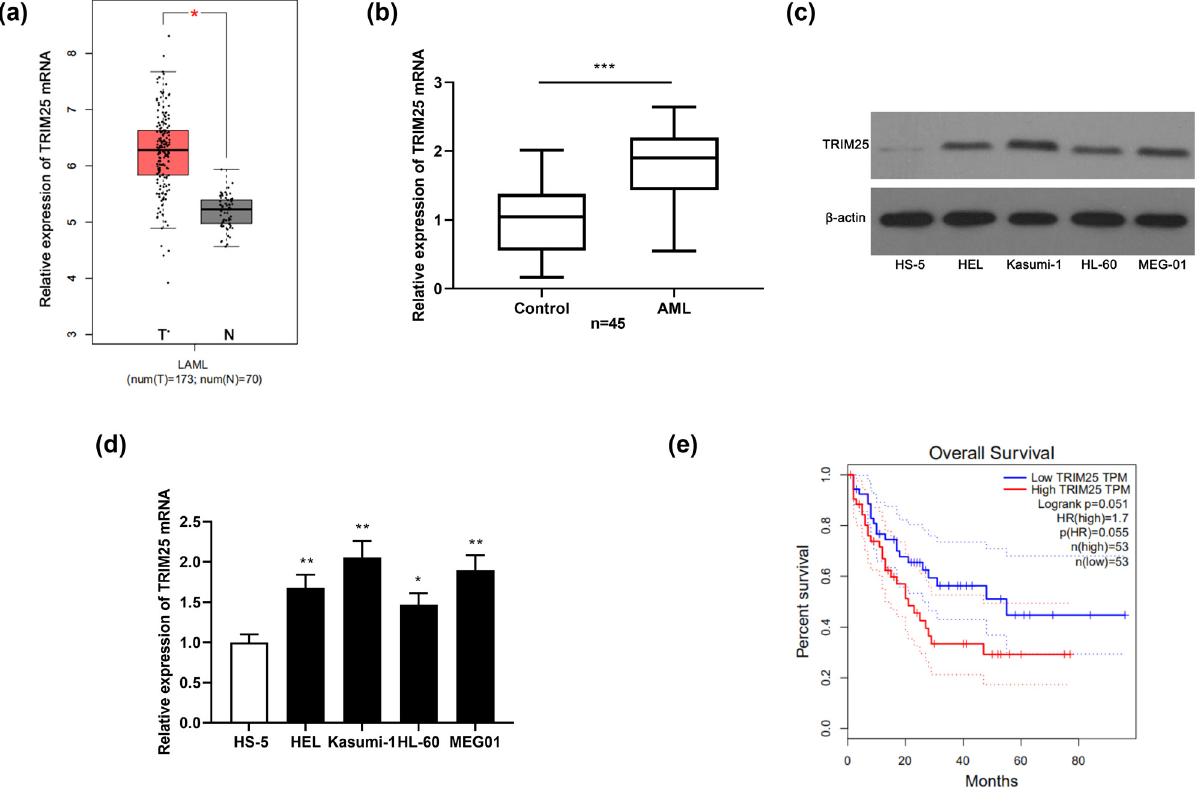
Figure 1: TRIM25 was highly expressed in AML samples and cells and was related to poor prognosis. ( a ) GEPIA database to retrieve TRIM25 expression in AML. ( b ) qPCR to assay TRIM25 mRNA expression in samples from 45 patients with AML and 45 healthy volunteers. ( c and d ) Western blot and qPCR to determine TRIM25 protein and mRNA expression in AML cells and HS - 5 cells. ( e ) GEPIA database to analyze the correlation between the expression level of TRIM25 and the prognosis of patients with AML. * P < 0.05, ** P < 0.01, *** P <